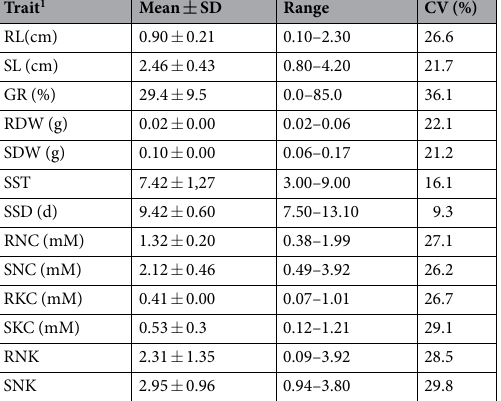
Table 1. Performances of salt tolerance related traits measured at germination and seedling stages of the 208 rice germplasms. 1 RL: root length, SL: seedling length, GR: germination rate, RDW: root dry weight, SDW: seedling dry weight, SST: score for salt toxicity symptoms, SSD: seedling survival days, RNC: root Na + concentration, SNC: shoot Na + concentration, RKC: root K + concentration; SKC: shoot K + concentration, RNK: ratio of Na + to K + concentrations in roots; SNK: ratio of Na + to K + concentrations in shoots.